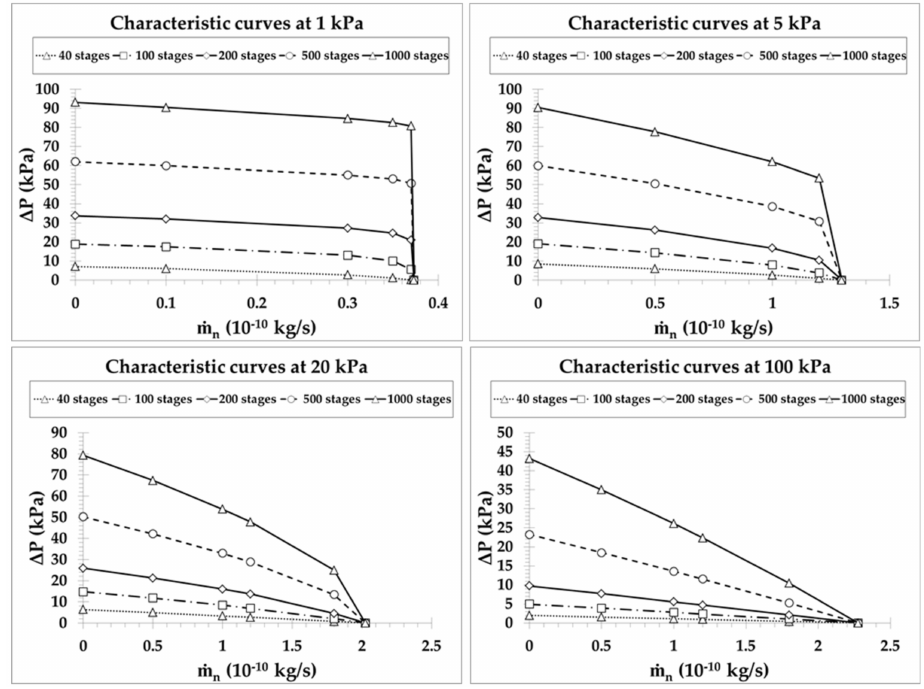
Figure 10. Performance characteristic curves of a Knudsen pump, based on pump C, for a number of stages N = 40,100,200,500,1000 with inlet pressures P in = 1,5,20,100 kPa when narrow microchannels diameter d = 10 µ m and wide channel diameter D = 100 µ